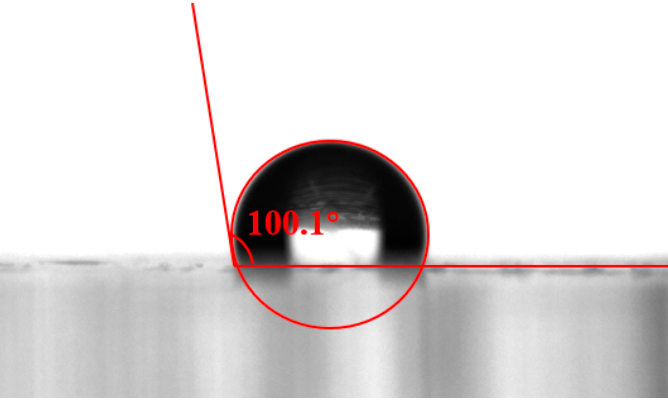
Figure 23. Measurement value of the contact angle of square-column triangle secondary microstructures.